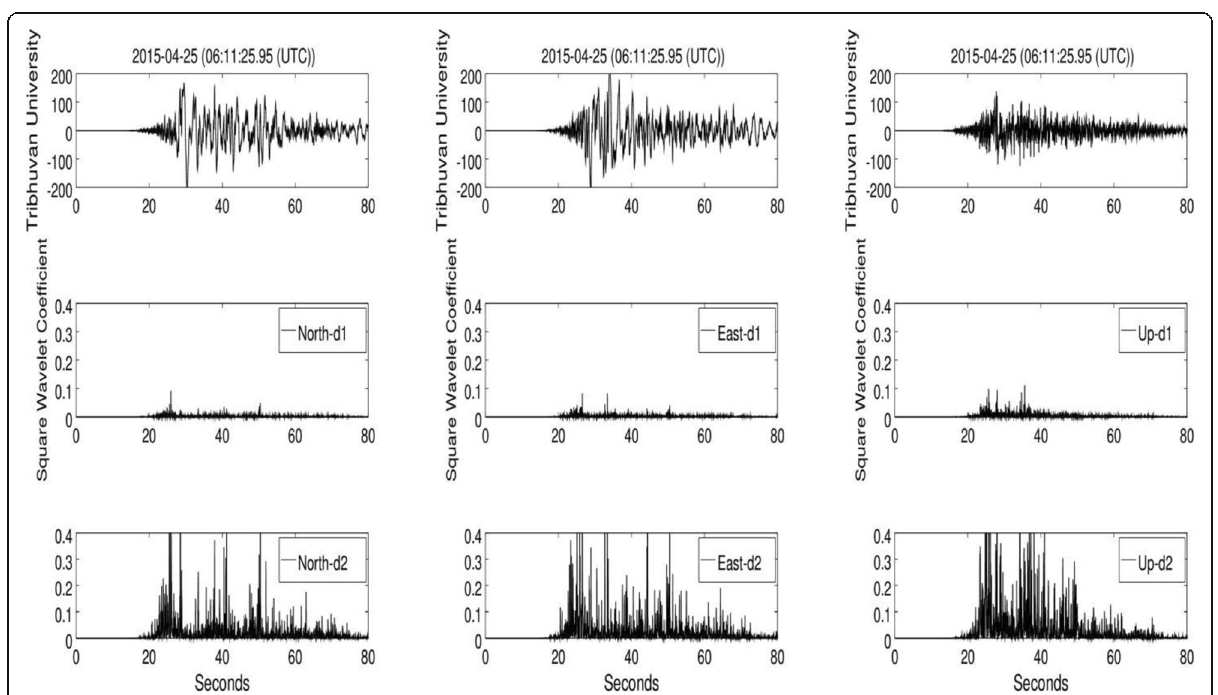
Fig. 12 Square wavelet coefficient dj (j = 1 and 2) of ground motion in NS, EW and vertical direction observer at TVU station